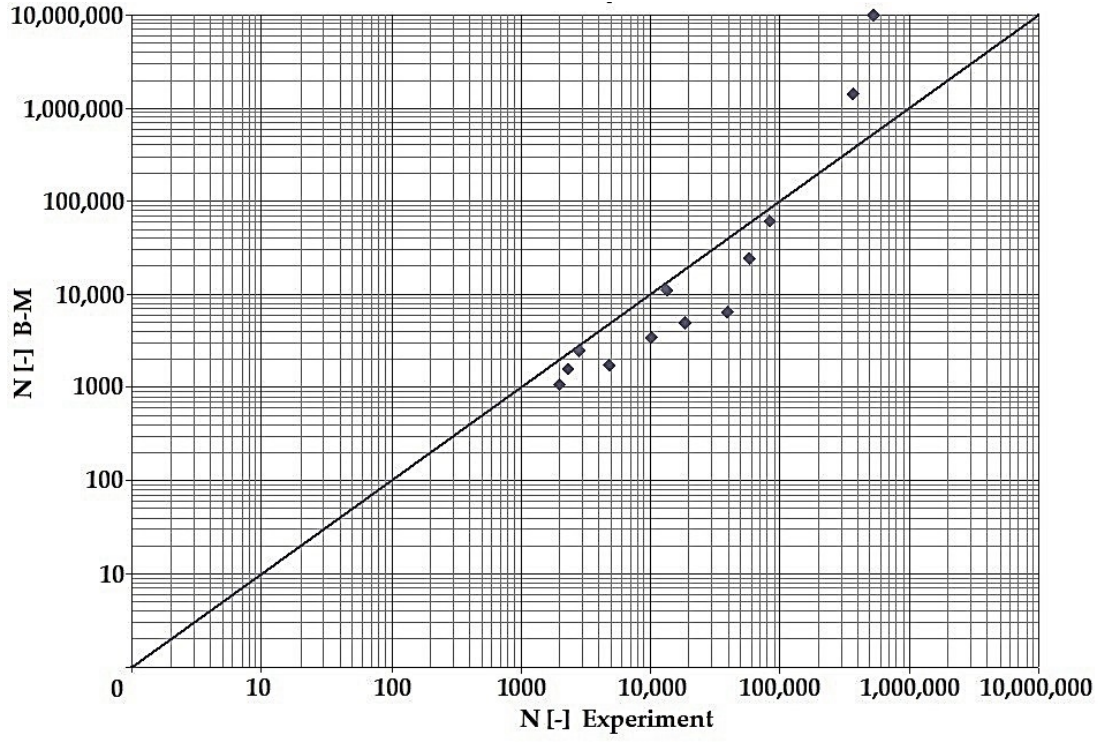
Figure 22. Dependence of theoretical and experimentally obtained number of cycles, Brown–Miller vs. experiment, phase shift 90°.